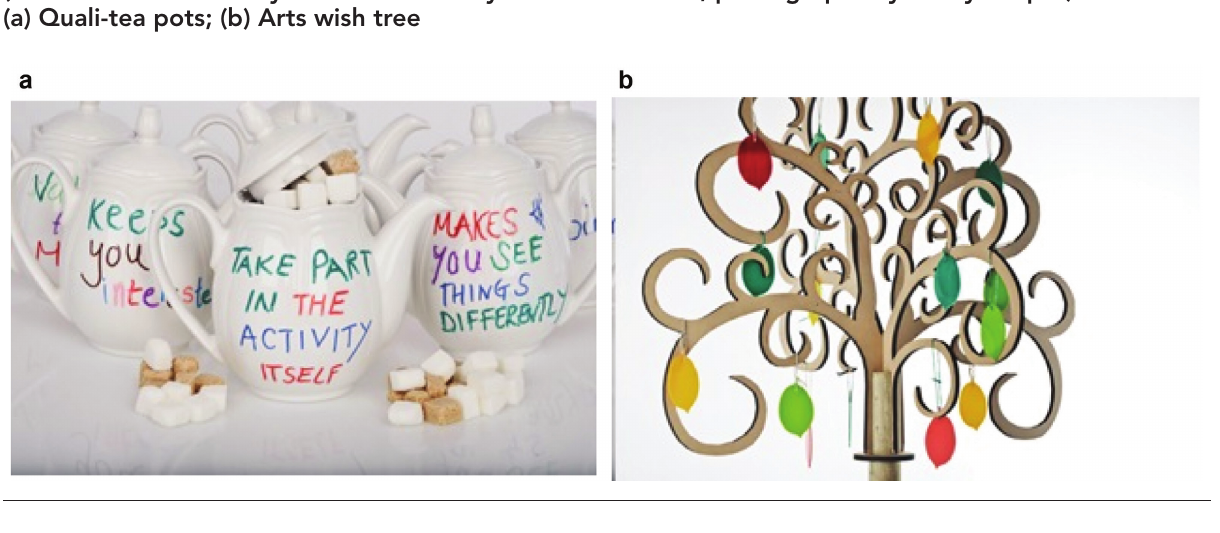
Figure 2. Examples of creative consultation techniques used during Appetite’s Taster Menu (Source: intervention by Nicola Winstanley and Sarah Nadin, photographs by Jenny Harper).